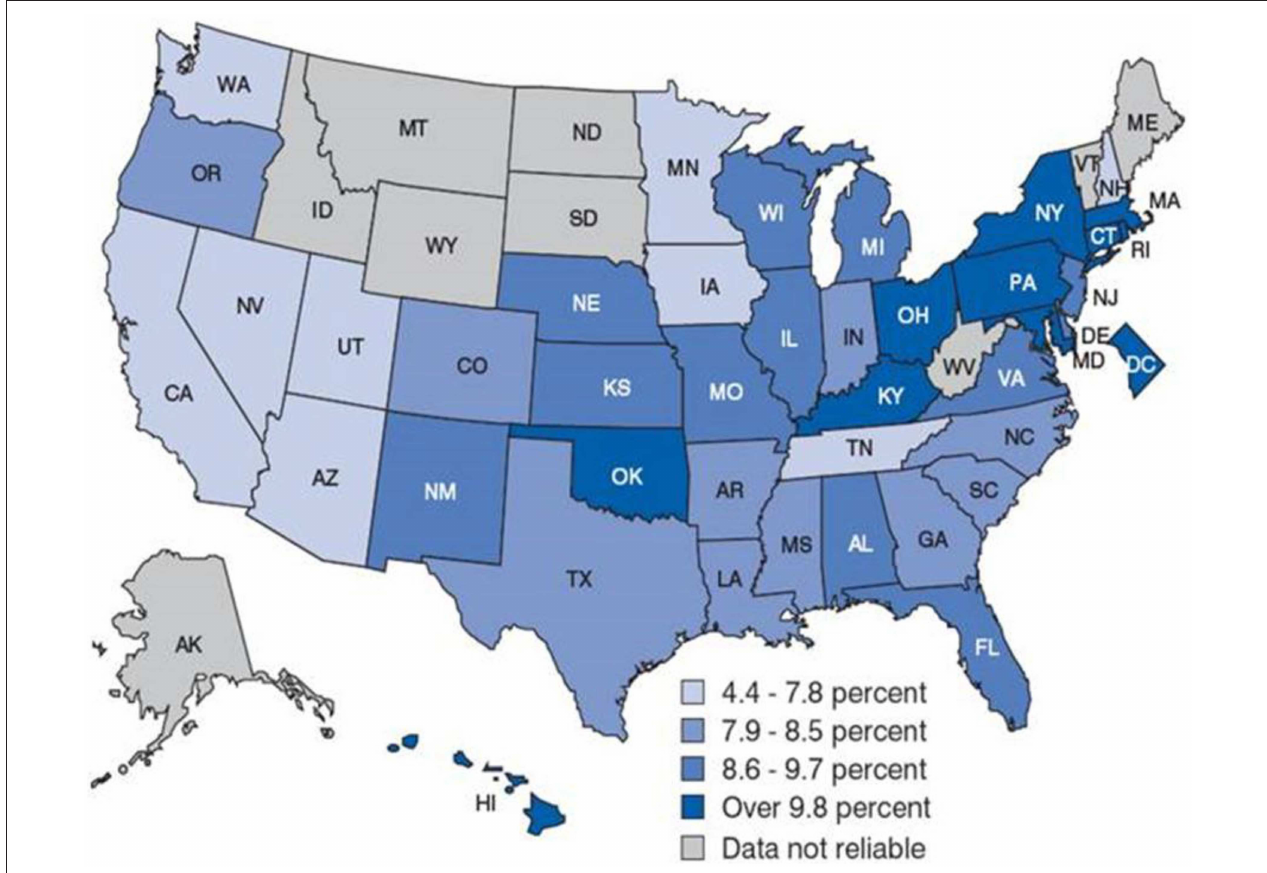
FIGURE 1 | Childhood asthma prevalence by state-by-state in the United States. Asthma prevalence rates are generally higher in the Northeast region. This could attribute to the population composition. For example, the Puerto Rican population, in which asthma prevalence is highest, tends to be concentrated in the Northeast region of the country. Source: CDC/NCHS, National Health Interview Survey, annual average for the period